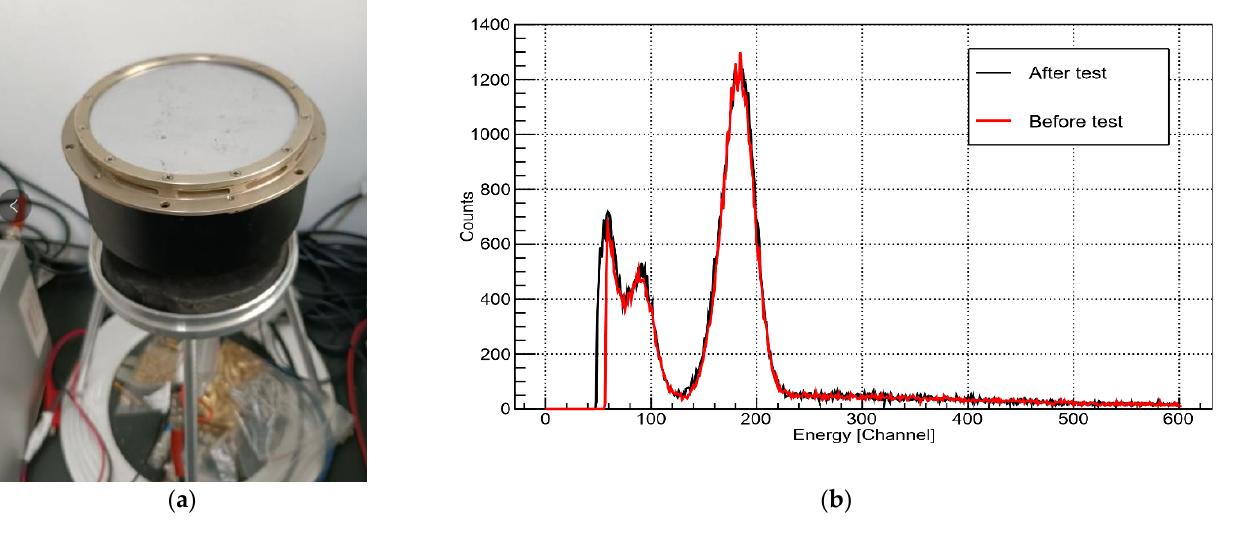
Figure 14. Performance test before and after mechanical vibration test: ( a ) Performance test site. ( b ) Result of performance test.